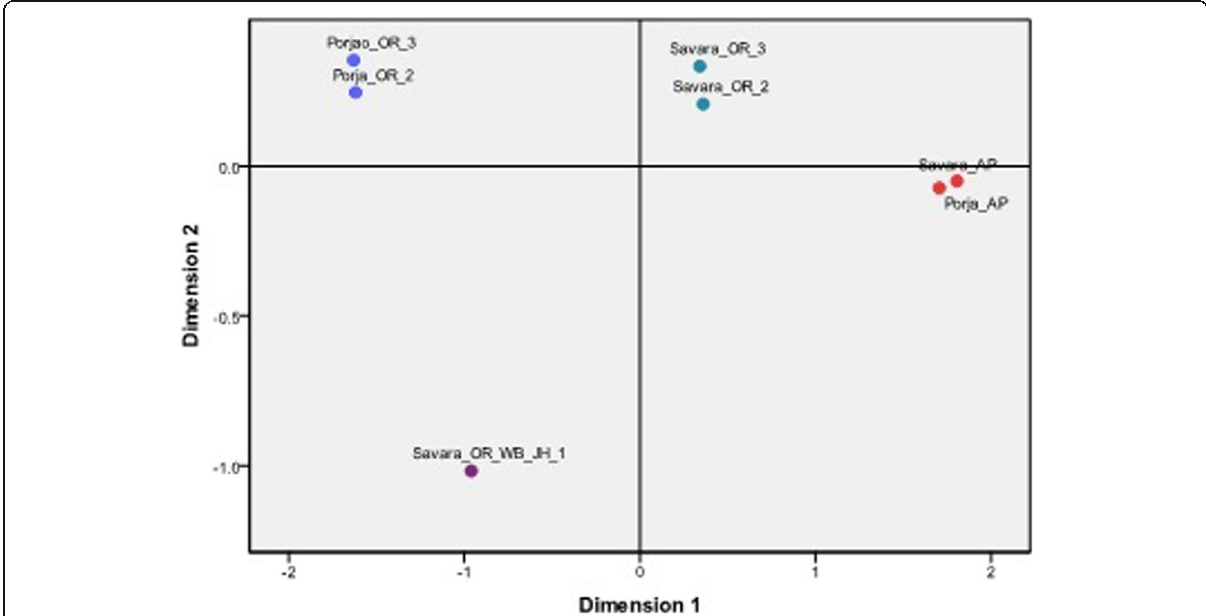
Fig. 4 Genetic relationships of populations based on Ø/ST distances estimated from Y chromosome haplogroup frequencies. AP Andhra Pradesh, OR Orissa, WB West Bengal, JH Jharkhand. Present studied samples (Savara and Porja) from AP are compared with the data set of Vikrant et al.